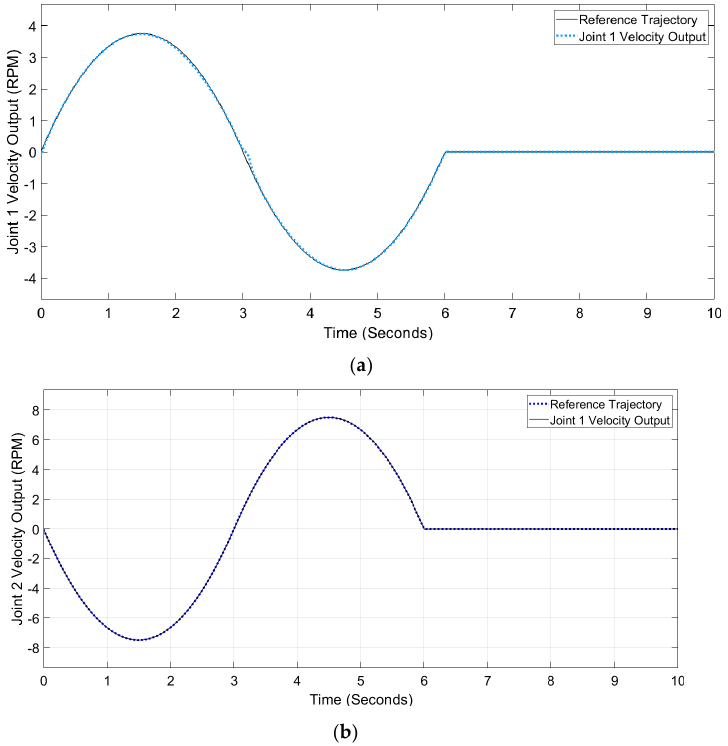
Figure 25. ( a ) Experimental velocity responses of shoulder joint A/A ( θ 1 ); ( b ) Experimental velocity responses of shoulder joint F/E ( θ 2